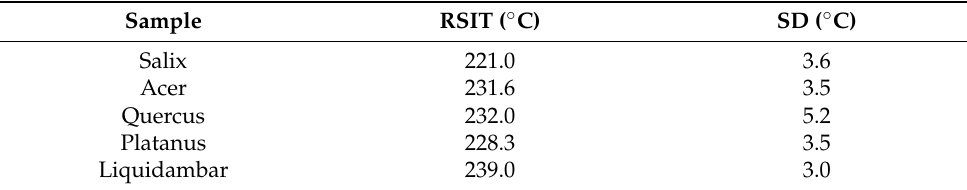
Table 4. Relative self-ignition temperature of tested sample